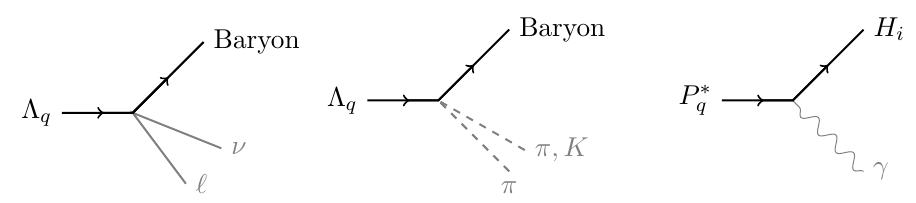
Figure 3 . The considered weak baryon decays (left two diagrams) and electromagnetic vector meson decay (right